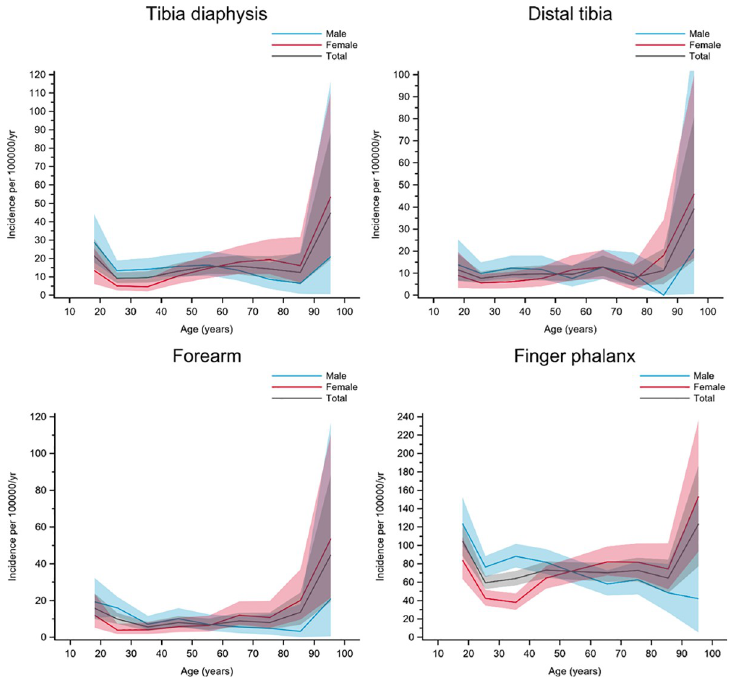
Fig 6. Fractures in group E. Age- and gender-specific incidence with 95% confidence interval. Black line represents the total population; red line represents females and blue line represents males.